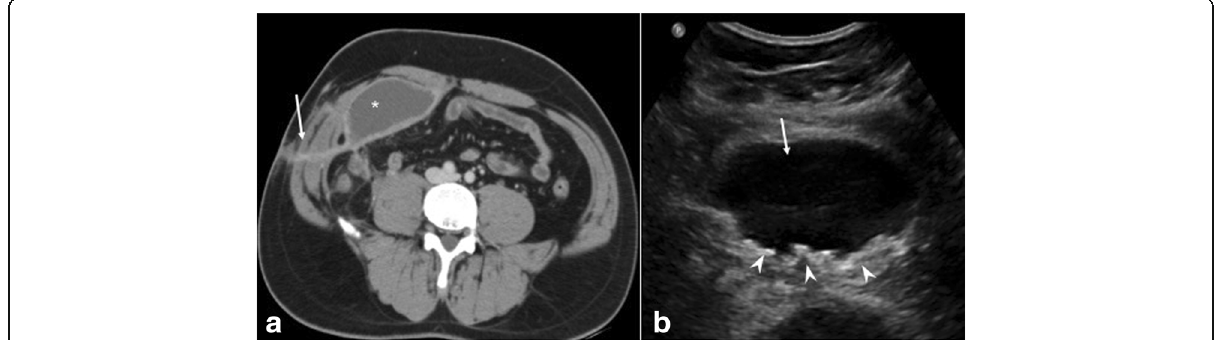
Fig. 8 a CECT axial section in a stab injury related hernia post mesh repair shows infected collection (*) with sinus tracks (arrow). b USG of the same shows collapsed mesh (arrowheads) within the collection